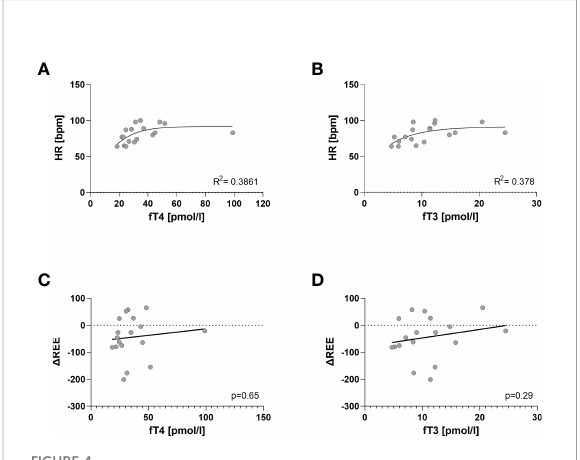
FIGURE 4 In fl uence of thyroid hormon levels on HR and D REE. Non-Linear Regression shows a positive correlation between HR and thyroid hormone levels; fT4 (R 2 = 0.39, p=0.026) (A) and fT3 (and R 2 = 0.38, p=0.029) (B) . D REE did not correlate with level oft fT4 (p= 0.65) (C) or fT3 (p= 0.29) (D) respectively. The degree of hyperthyroidism did not affect the response of REE to